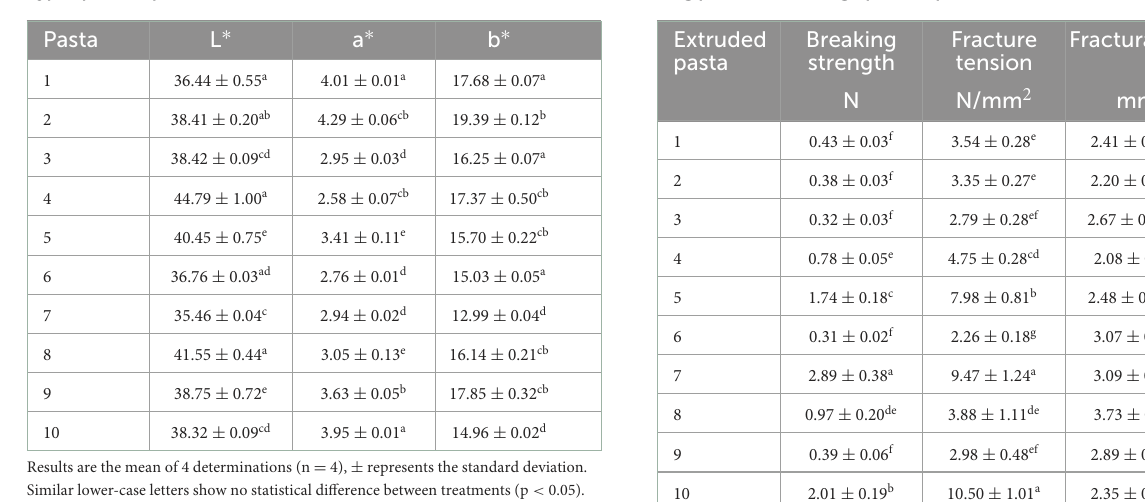
TABLE 5 Results of textural characterization by three-point test on long pasta based on high protein